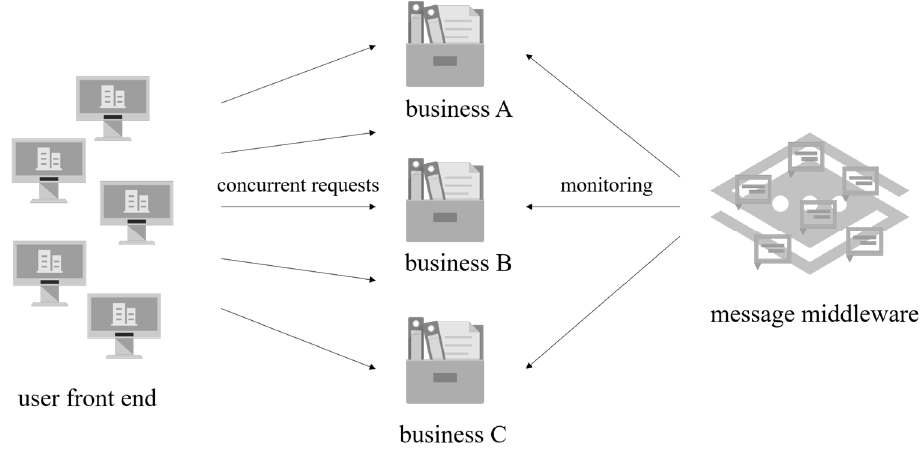
Figure 2. Business system monitoring the message middleware.